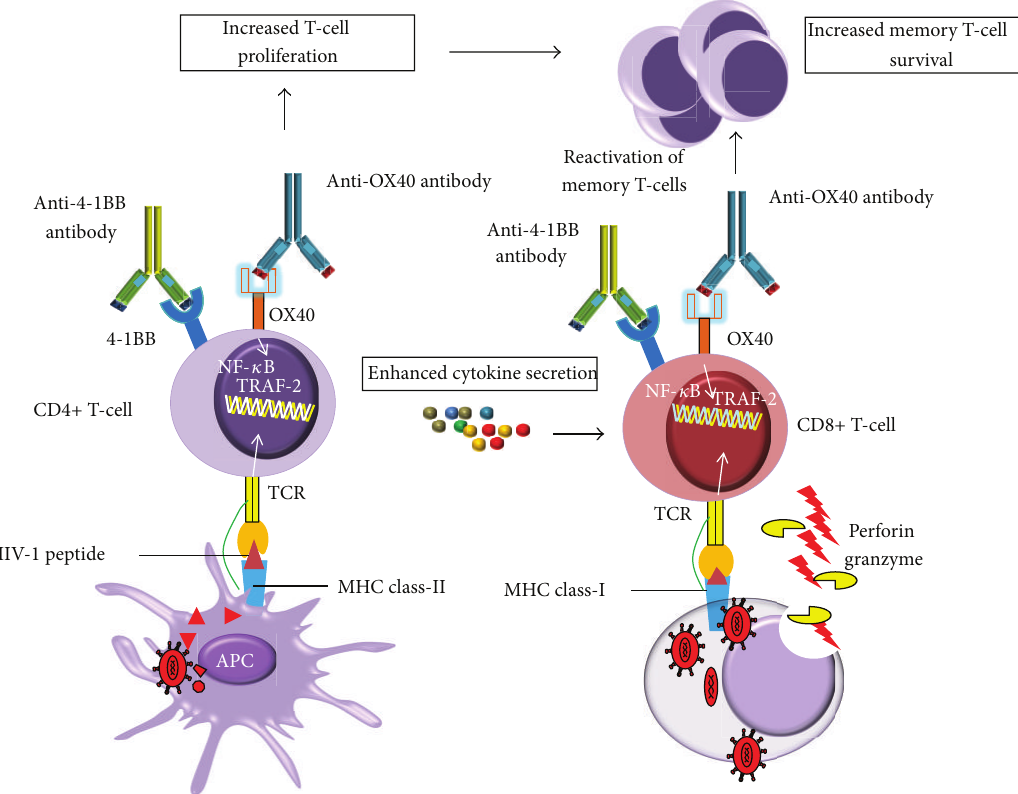
Figure 3: 4-1BB and OX40 signaling enhance anti-HIV immunity, leading to therapeutic effects. Agonists 4-1BB or OX40 specific antibodies can induce enhanced anti-HIV T cell (CD4+ and CD8+ T cell) response in HIV-1 infected patients. The ligation of OX40/4-1BB antibodies activates OX40/4-1BB signaling that results in enhanced CD4+ T cell response through increased cytokine production and increased survival of memory T cells. TRAFs and NF-kappaB signaling has been shown to be important for the generation of memory T cells. Potential antiviral mechanisms of OX40/4-1BB include an increase in CD8+ T cell cytotoxicity through perforins and granzymes and an increase in Fas/FasL mediated HIV-infected cell